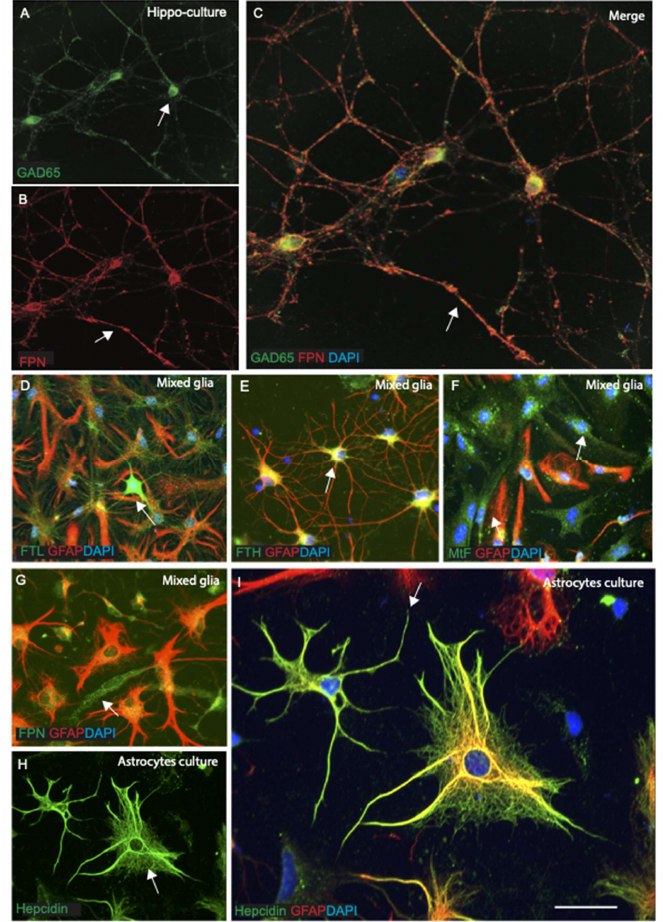
Figure 8. Expression of iron proteins in primary cultures of hippocampal neurons and astrocytes. To investigate the expression of ferroportin in vitro, we grew primary cultures of hippocampal neurons and astrocytes from rat brains. Ferroportin was observed in cultured hippocampal neurons in the nucleus and perinuclear cytoplasm, and in axons/dendrites (in the dendritic spines) and photographed using confocal microscope ( A – C ). Hippocampal neurons were co-localised with GAD65 (a marker for GABA) ( C ). Mixed glial cells were stained with each ferritin antibodies and glial fibrillary protein (GFAP) to identify astrocytes ( D – F ). FTL was seen in the cell body and in the processes that co-localised with GFAP positive astrocytes ( D ), whereas FTH showed prevalence in the oligodendrocyte-like structures ( E ); a large proportion of mixed glial cells were MtF positive and GFAP negative ( F ). Another slide was stained with ferroportin and GFAP, some bipolar cells were ferroportin positive and GFAP negative ( G ). Astrocytes in culture were stained with hepcidin and GFAP; hepcidin expressed in the cell body and extended into the processes ( H ). Hepcidin expression was present in perinuclear location and as well as in the growth cone ( H , I ). Scale bar: ( A – C , H , I ) = 10 µ m, ( D – G ) = 20 µ